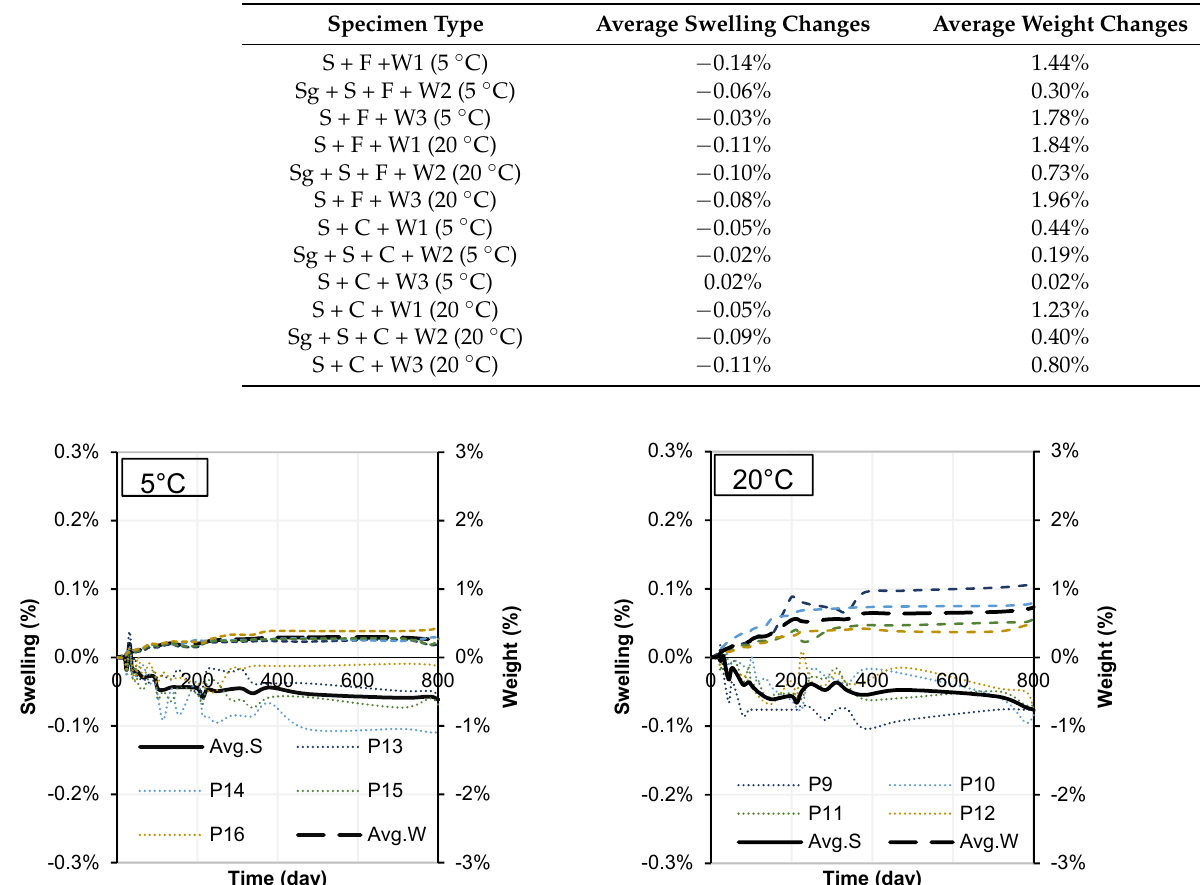
Table 5. Average confined swelling and weight changes. S: soil, Sg: subgrade soil, F: WPFA, C: cement.